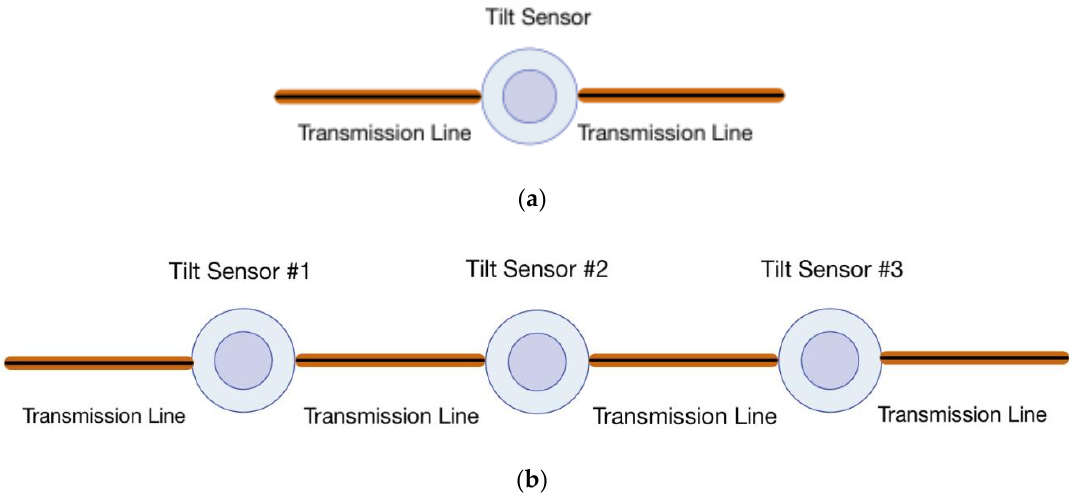
Figure 8. The ETDR test setups consisted of connecting ( a ) a capacitive tilt sensor and ( b ) three tilt sensors in series by 25 ft long cables at opposite ends to form the entire transmission line.